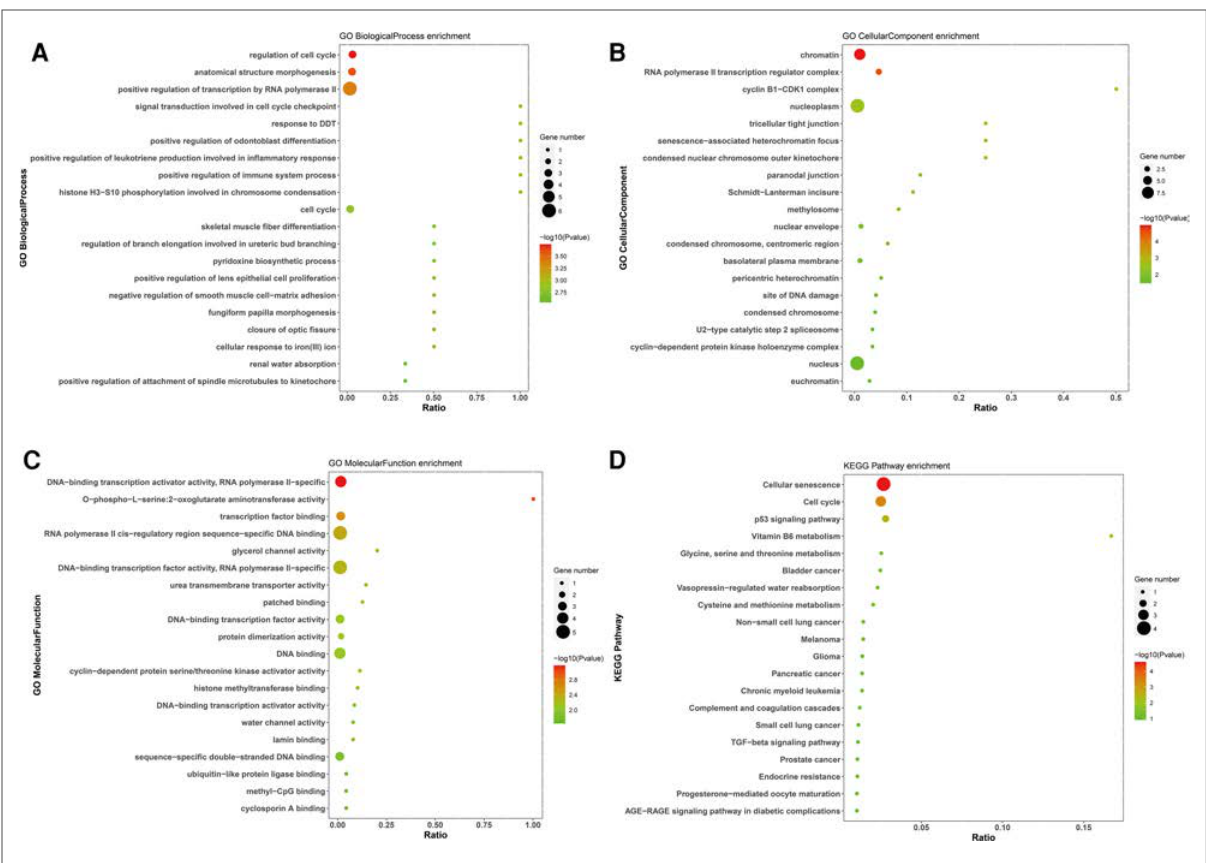
FIGURE 5 Go and KEGG enrichment analysis of up-regulated survival-associated mRNAs. ( A – C ) GO analysis of up-regulated mRNAs. ( D ) KEGG analysis of up- regulated